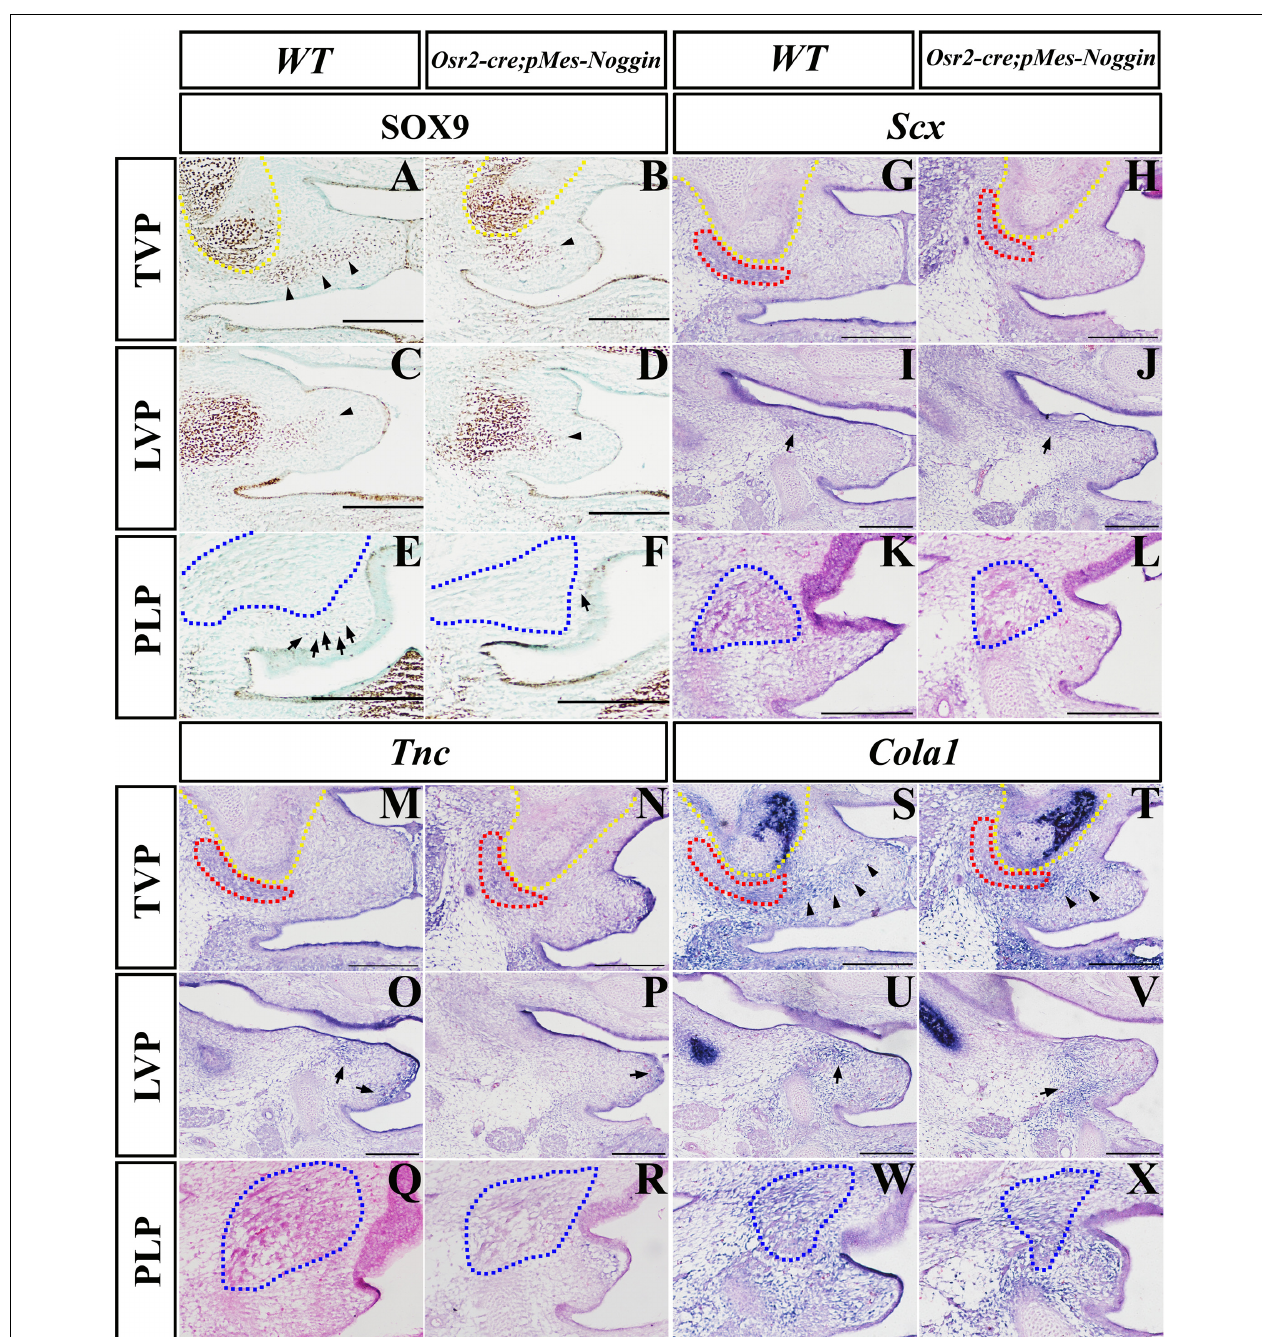
FIGURE 4 | The Sox9, Scx , TnC , and Col1a1 expression in Osr2-cre KI ;pMes-Noggin soft palates. (A–F) The immunostaining of Sox9 in the E14.5 WT soft palate at the TVP (A) , LVP (C) , and PLP (E) levels, and the E14.5 Osr2-cre KI ;pMes-Noggin soft palate at the TVP (B) , LVP (D) , and PLP (F) levels. The arrowheads in (A–D) point to the Sox9 domain in the mesenchyme. The arrows in (E,F) point to the Sox9-positive cells in the mesenchyme. (G–L) In situ hybridization of Scx in the E14.5 WT soft palate at the TVP (G) , LVP (I) , and PLP (K) levels, and the E14.5 Osr2-cre KI ;pMes-Noggin soft palate at the TVP (H) , LVP (J) , and PLP (L) levels. The arrows in (I,J) point to the LVP areas. (M–R) In situ hybridization of TnC in the E14.5 WT soft palate at the TVP (M) , LVP (O) , and PLP (Q) levels, and the E14.5 Osr2-cre KI ;pMes-Noggin soft palate at the TVP (N) , LVP (P) , and PLP (R ) levels. The arrows in (O,P) point to the TnC -positive areas. (S–X) In situ hybridization of Col1a1 in the E14.5 WT soft palate at the TVP (S) , LVP (U) , and PLP (W) levels, and the E14.5 Osr2-cre KI ;pMes-Noggin soft palate at the TVP (T) , LVP (V) , and PLP (X) levels. The arrowheads in (S,T) delineate the Col1a1 -positive areas along the presumptive aponeurosis. The arrows in (U,V) point to the Col1a1 -positive areas. The yellow dotted lines delineate the HPPs; the red dotted lines circle TVPs; the blue dotted lines delineate SPCs and PLPs. Scale bars are 200 µ m. TVP, tensor veli palatini; LVP, levator veli palatini; PLP, palatopharyngeus; HPP, hypophosphatasia; SPC, superior pharyngeal constrictor.